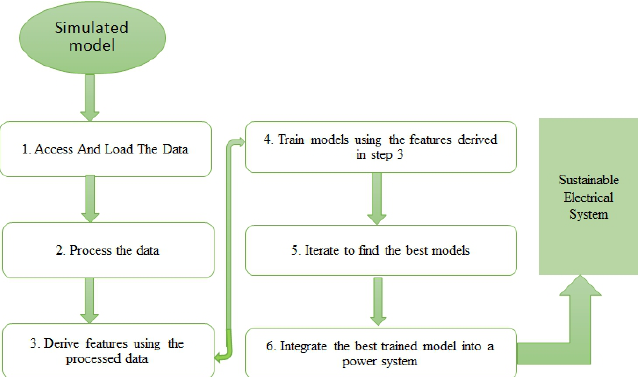
Figure 3. The data processing model for machine